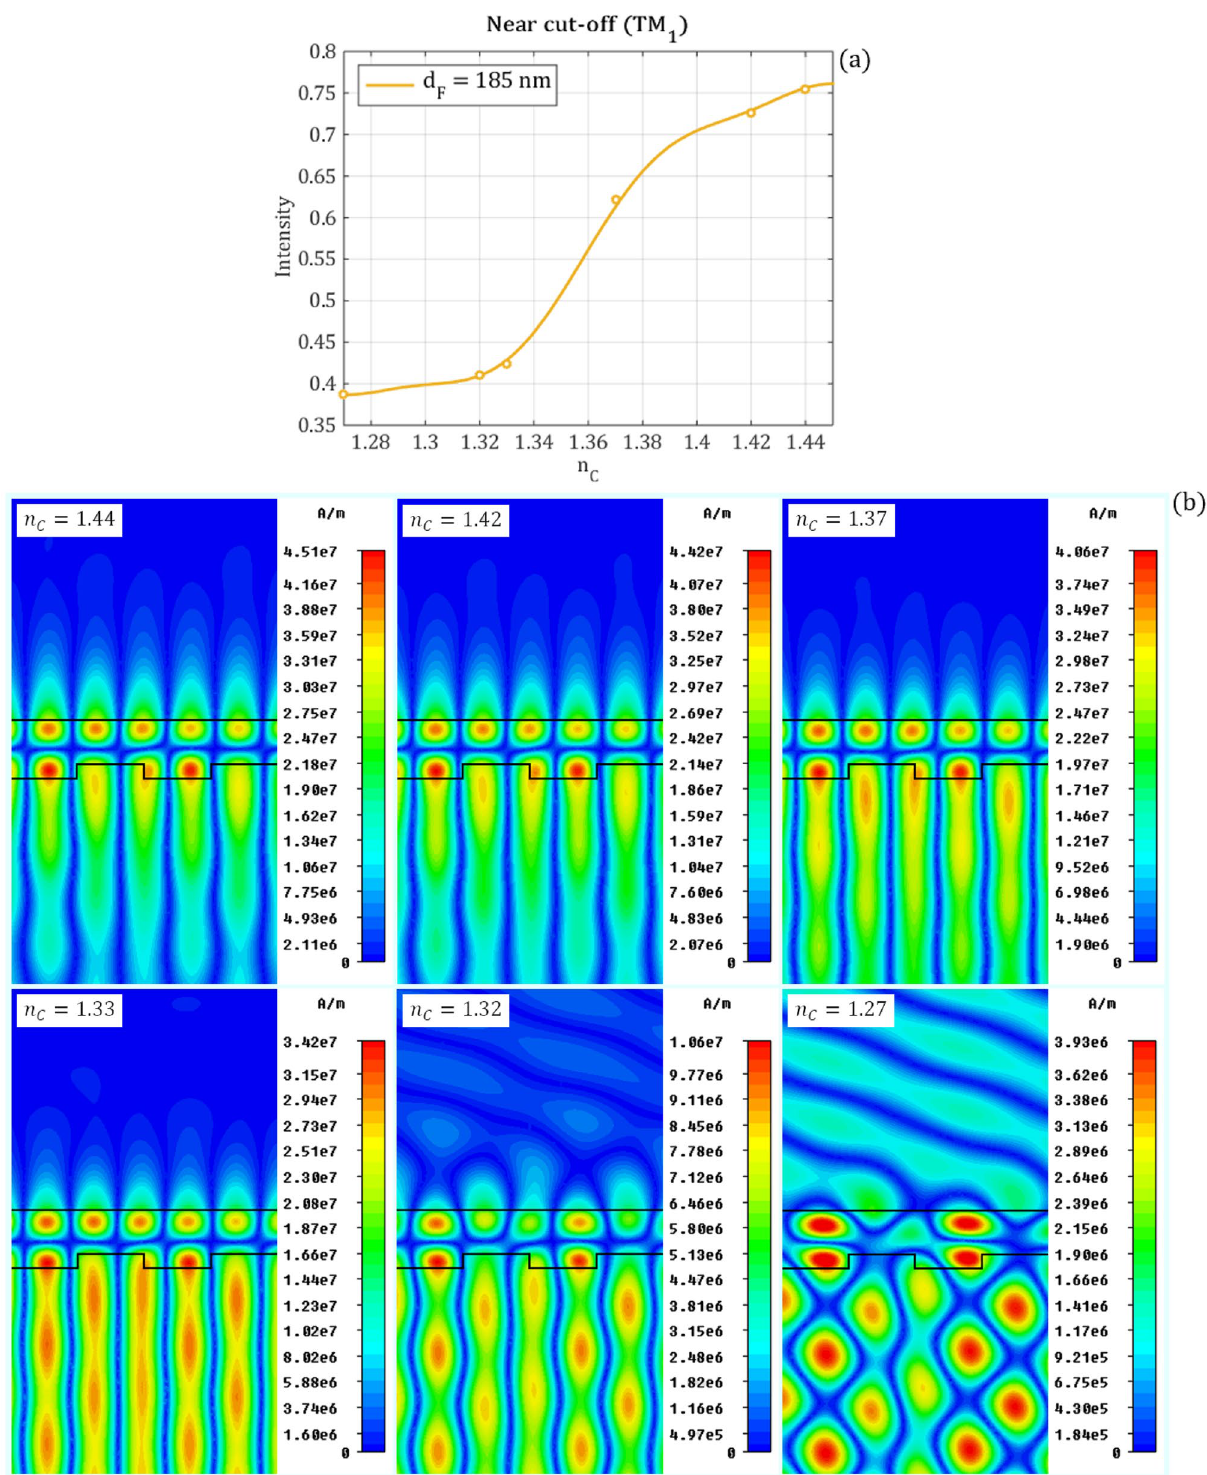
Figure 11. ( a ) The intensity of the near cut-off peak as a function of the refractive index of the cover layer for d F = 185 nm waveguide film thickness. The magnetic field distributions corresponding to the refractive index values marked with circles are shown in ( b ). Decreasing the cover refractive index, the localization of the magnetic field decreases, and after the cut-off point, which is around n C = 1.33 − 1.32 the wave propagates through the waveguide. The magnetic field distributions are calculated by CST Studio Suit 37